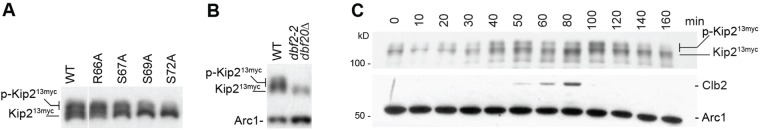
Dbf2 and additional kinases act on Kip2 as a priming kinases for GSK-3. (A) Amino acids at positions S69 and S72, downstream of S63 act presumably as phosphorylation priming sites for Mck1. Western blots of the indicated Kip213myc variants. Kip213myc phosphorylation is reduced upon mutation of the indicated sites. (B) Kip213myc phosphorylation is clearly reduced in dbf2-2 dbf20Δ mutants. (C) Kip2 phosphorylation is cell-cycle regulated and increases in anaphase (western blot against Kip213myc of cell extracts from cells synchronized with α-factor for 3 h and released in fresh medium lacking the pheromone, at 30°C).